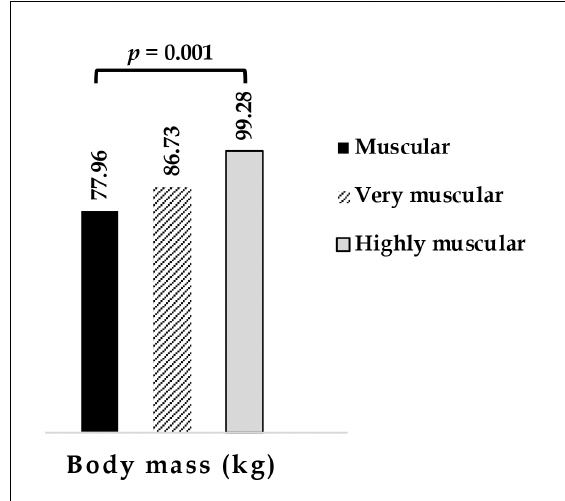
Figure 1. Differences in BM between the BMI group